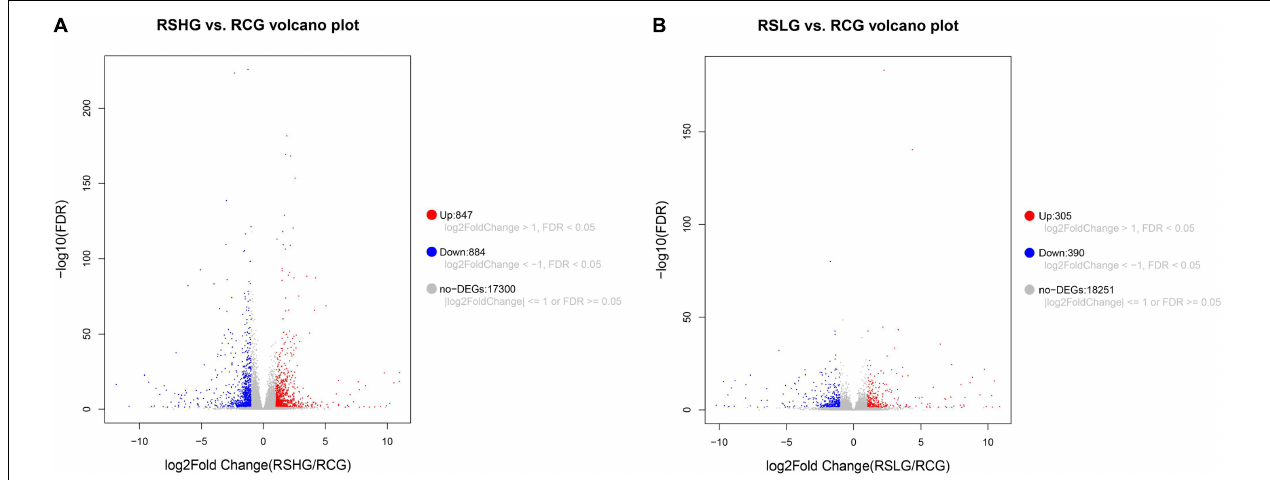
FIGURE 4 | Volcano plot of DEGs. (A) RSHG versus RCG volcano plot; (B) RSLG versus RCG volcano plot.